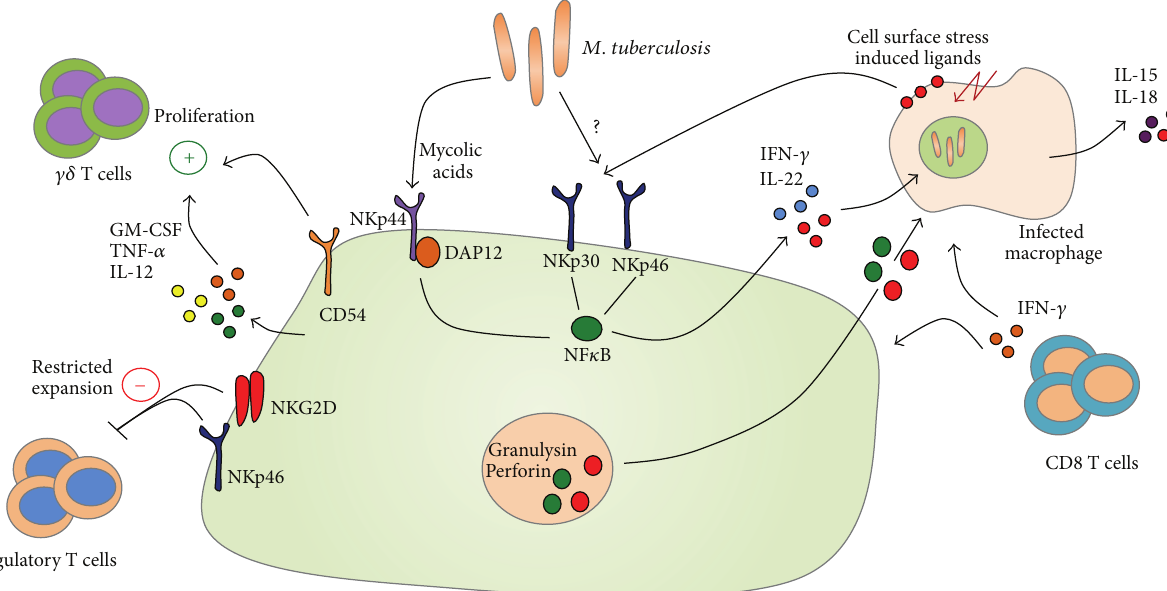
Figure 4: Natural killer (NK) cells have the capacity to restrict M. tuberculosis replication through the production of soluble mediators such as GM-CSF, IL-12, TNF- 𝛼 , IL-22, and IFN- 𝛾 . These upregulate the antimicrobial function of infected macrophages and activate antigen-specific T cell responses during M. tuberculosis infection. NK cell-derived antimicrobial factors such as granulysin and perforin indirectly restrict Mtb growth via the lysis of infected host cells. Several studies suggest that NK cells directly recognize Mtb-derived mycolic acids via NKp44. Aside from direct recognition of Mtb ligands, NKp30 and NKp46 recognize a variety of stress molecules upregulated on the surface of infected host